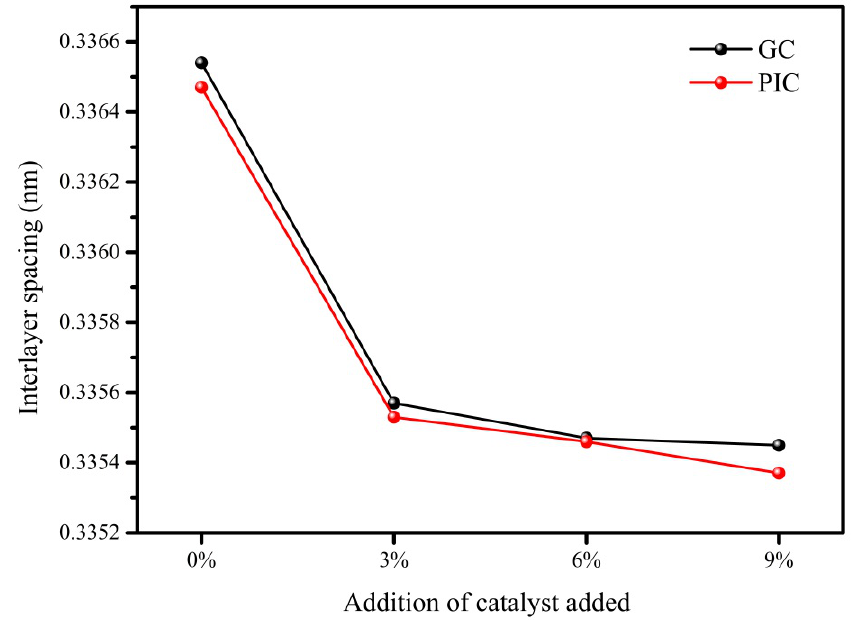
Figure 3. Interlayer spacings of the samples as a function of the amount of catalyst added.